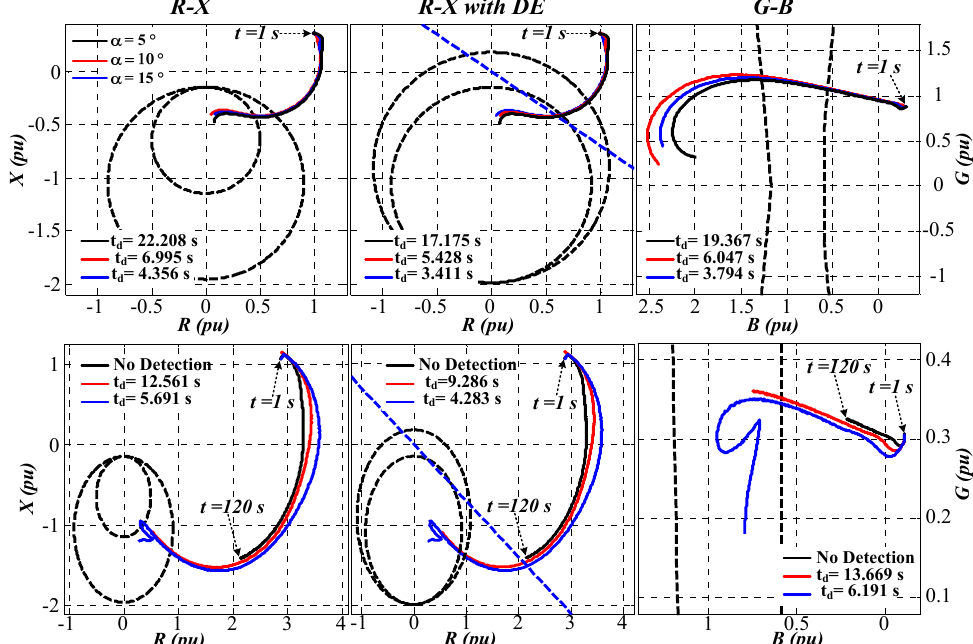
Figure 9. Performances of the traditional schemes during different PLOE failures in heavy loading (first row) and light loading (second row) conditions; including R–X scheme (first column), R–X scheme with DE (second column) and G–B scheme (third column).